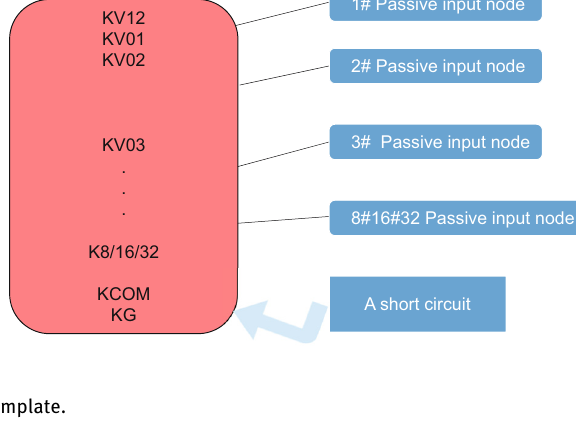
Figure 3: Data acquisition template.